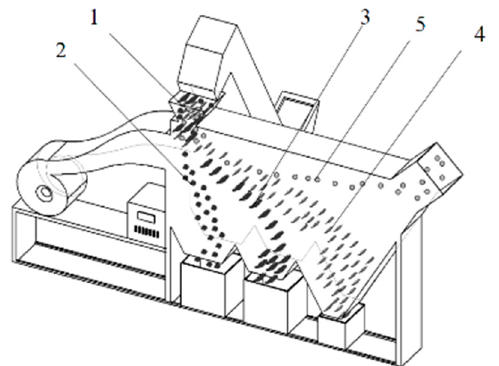
Figure 2. Working principle of the safflower separation and cleaning device. 1. Safflower impurities mixture; 2. Stones; 3. Bonded petals; 4. Safflower petals; 5. Dust.